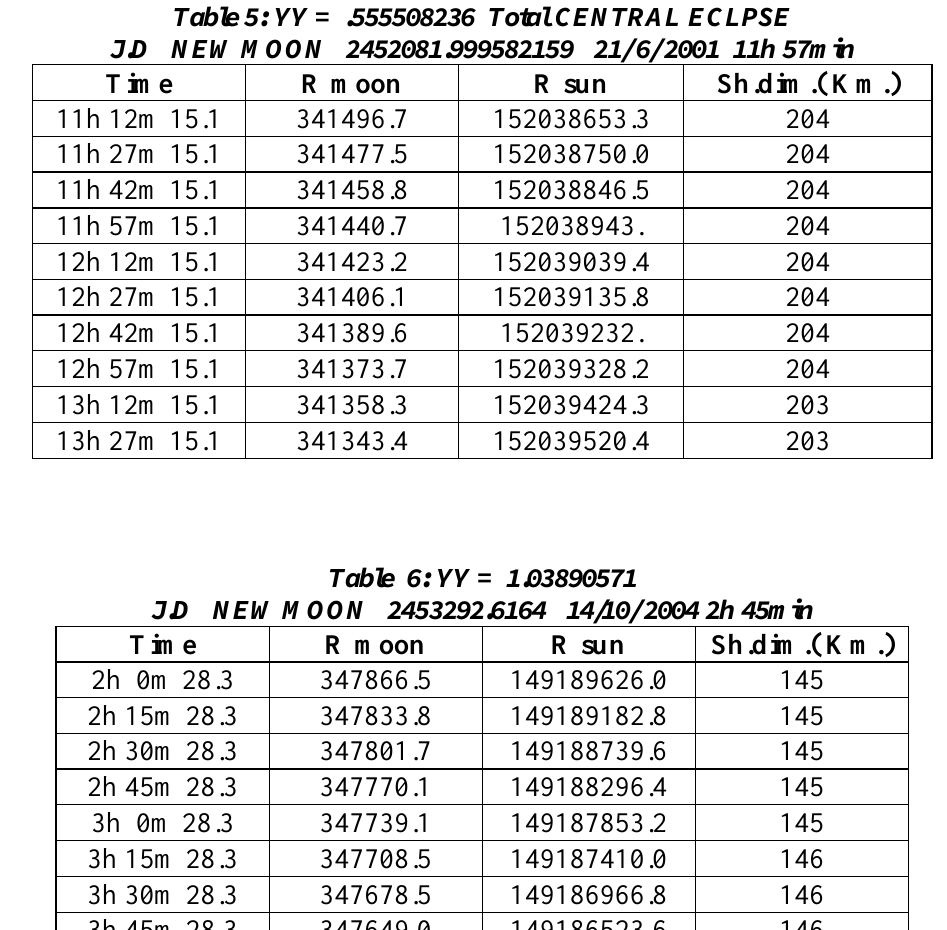
Table 5: YY = .555508236 Total CENTRAL ECLPSE